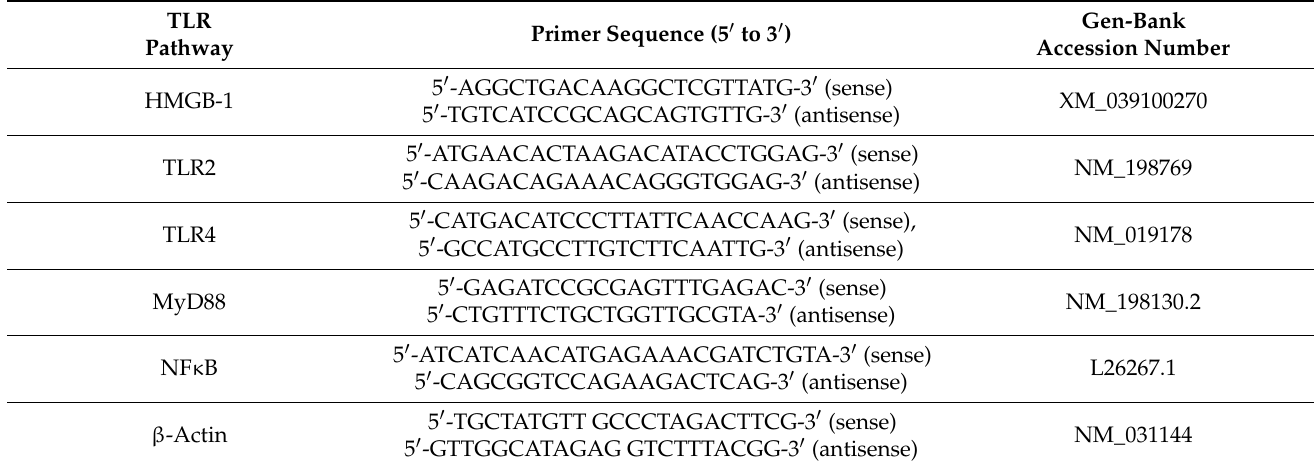
Table 2. Primer sequences used for qPCR of TLR pathway gene